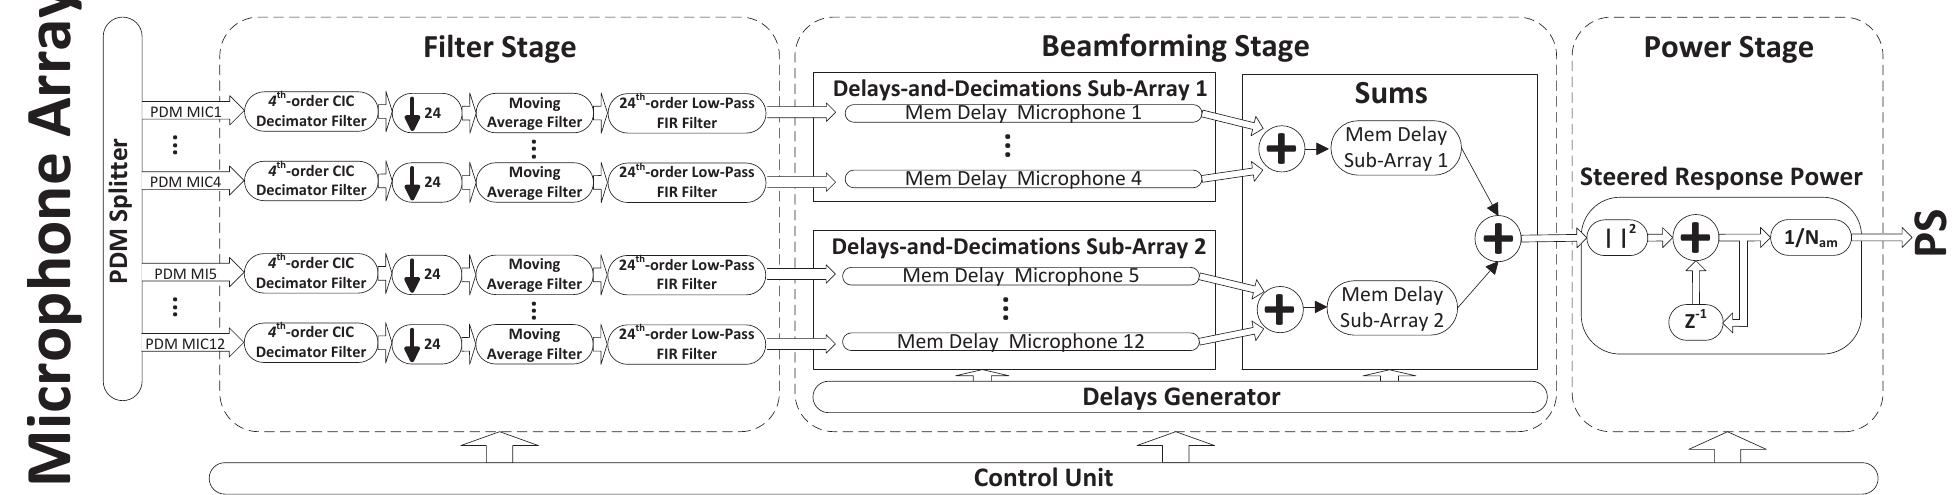
Figure 4. Overview of the FPGAs components. The PDM input signal is converted to audio in the cascade of filters. The Delay-Decimate-and-Sum beamformer is composed of several memories, associated to each sub-array to disable those memories linked to the deactivated microphones, to properly delay the input signal. The SRP is finally obtained per steering